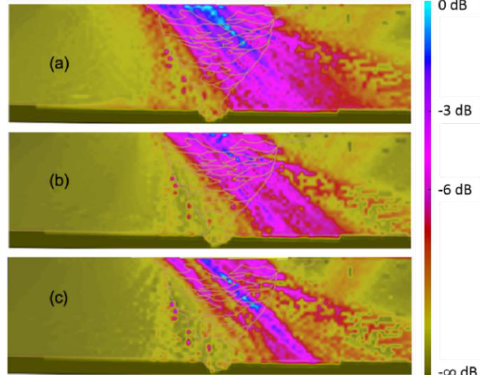
Figure 6. Longitudinal wave inspection. Scanning angle of 45°, index 23 mm. Number of elements: ( a ) 16, ( b ) 24 and ( c ) 32.